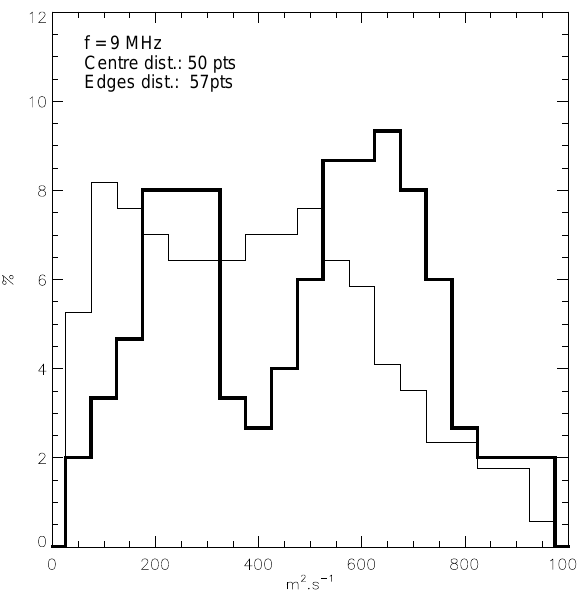
Fig. 4. Values of D measured in the center (bold line) and at the edges of the structures (thin line).